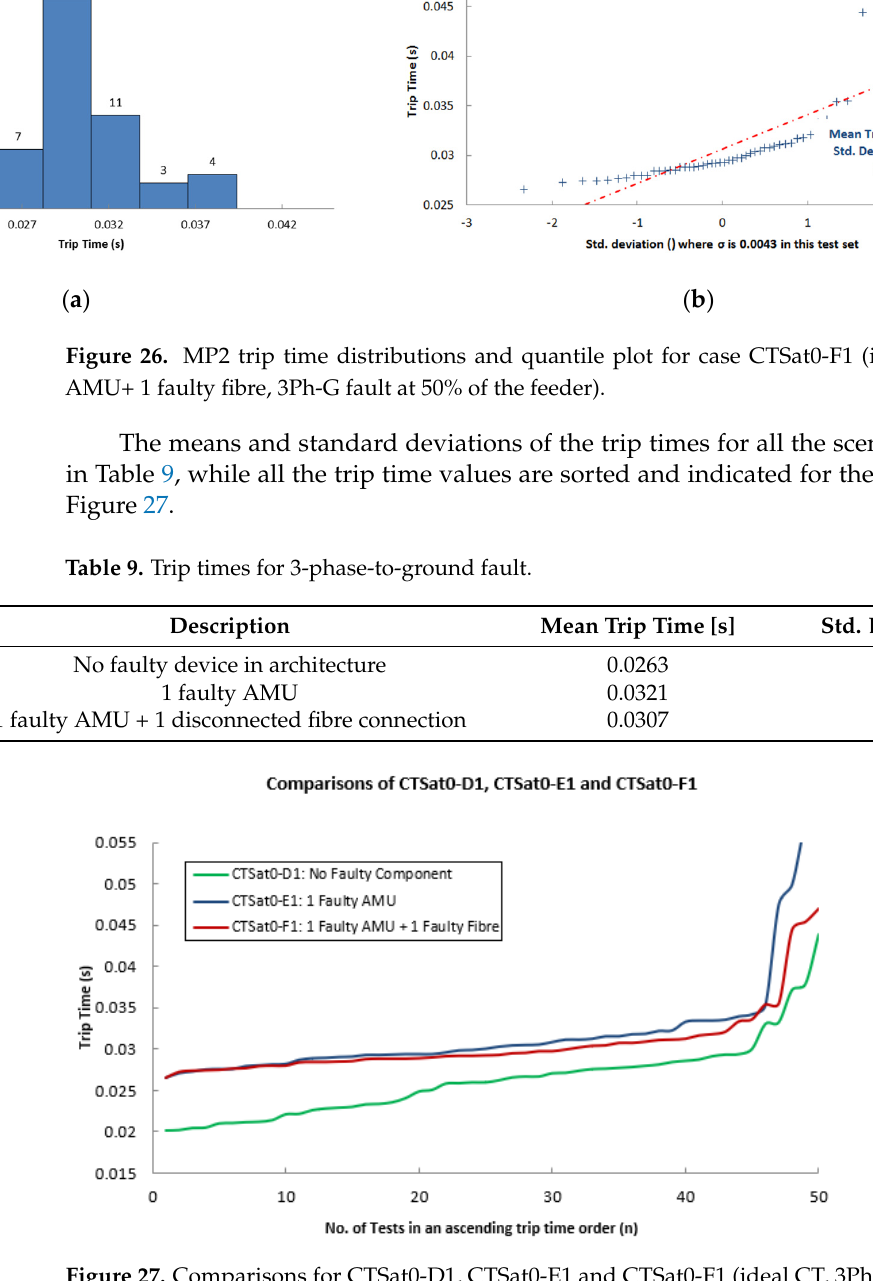
( b ) Figure 25. MP2 trip time distributions and quantile plot for case CTSat0-E1 (ideal CT, 1 faulty AMU, 3Ph-G fault at 50% of the feeder). Scenario CTSat0-F1: One Faulty AMU and Fibre in the PRP Configuration The state of the future intelligent transmission network substation architecture was further intentionally worsened for testing purposes by removing the fibre optics cable connecting the main Vendor 1 digital merging unit with Station Bus 1. After this fibre optics cable was disconnected, the Vendor 1 digital merging unit still had, according to the PRP architecture design requirements, a second connection for multicasting the trip